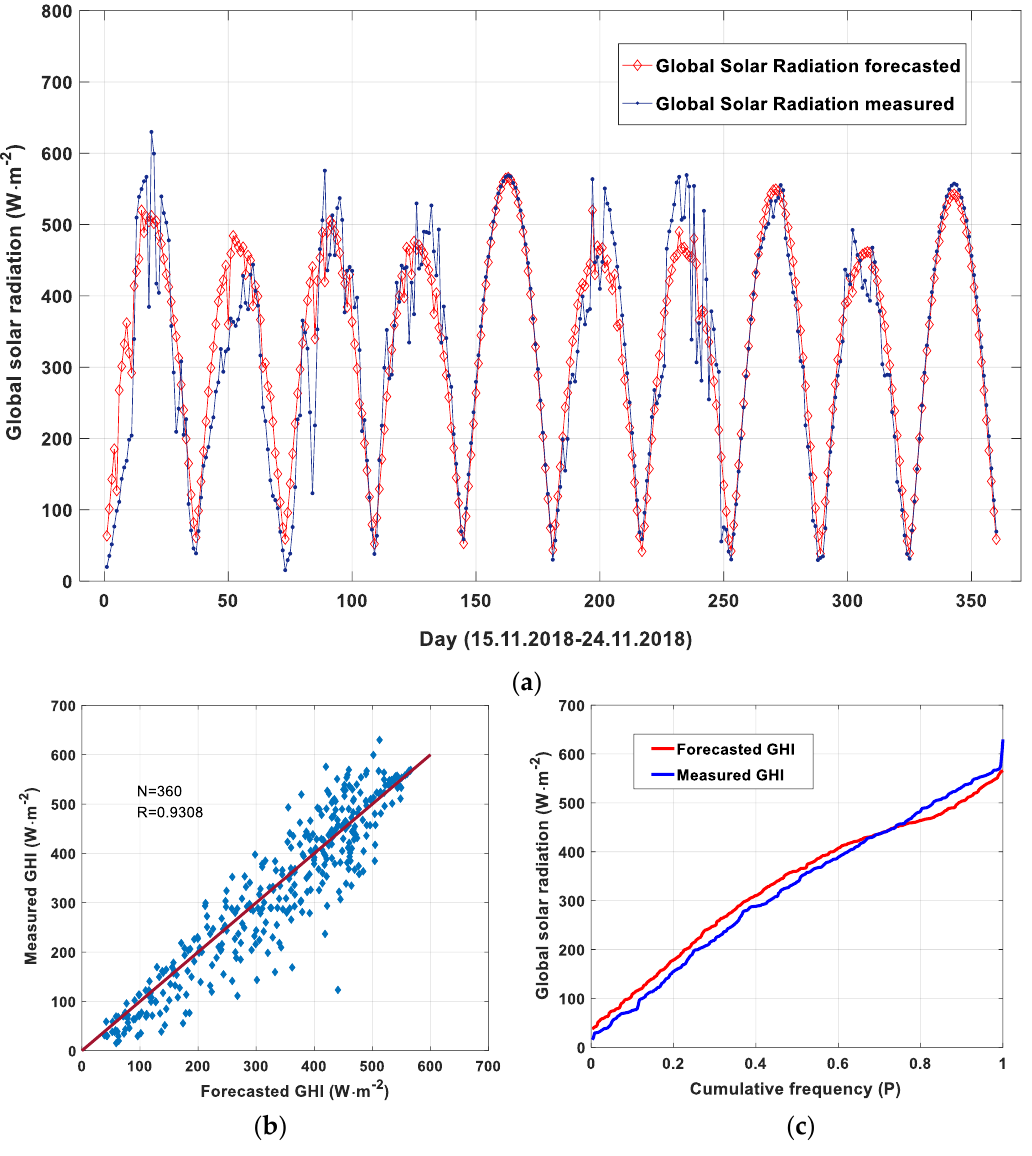
Figure Figure 8. The forecasted results of GHI under all condition days with a 60 min horizon (15.11.2018 – 24.11.2018), total of 360 samples of the test set: ( a ) Continuous diurnal variation curves; ( b ) Scatter diagram; ( c ) Cumulative frequency curves. Table 5. Statistical indexes under all sky conditions with horizons from 15 – 180 min (in W/m 2 for the RMSE, MAE, and MBE).